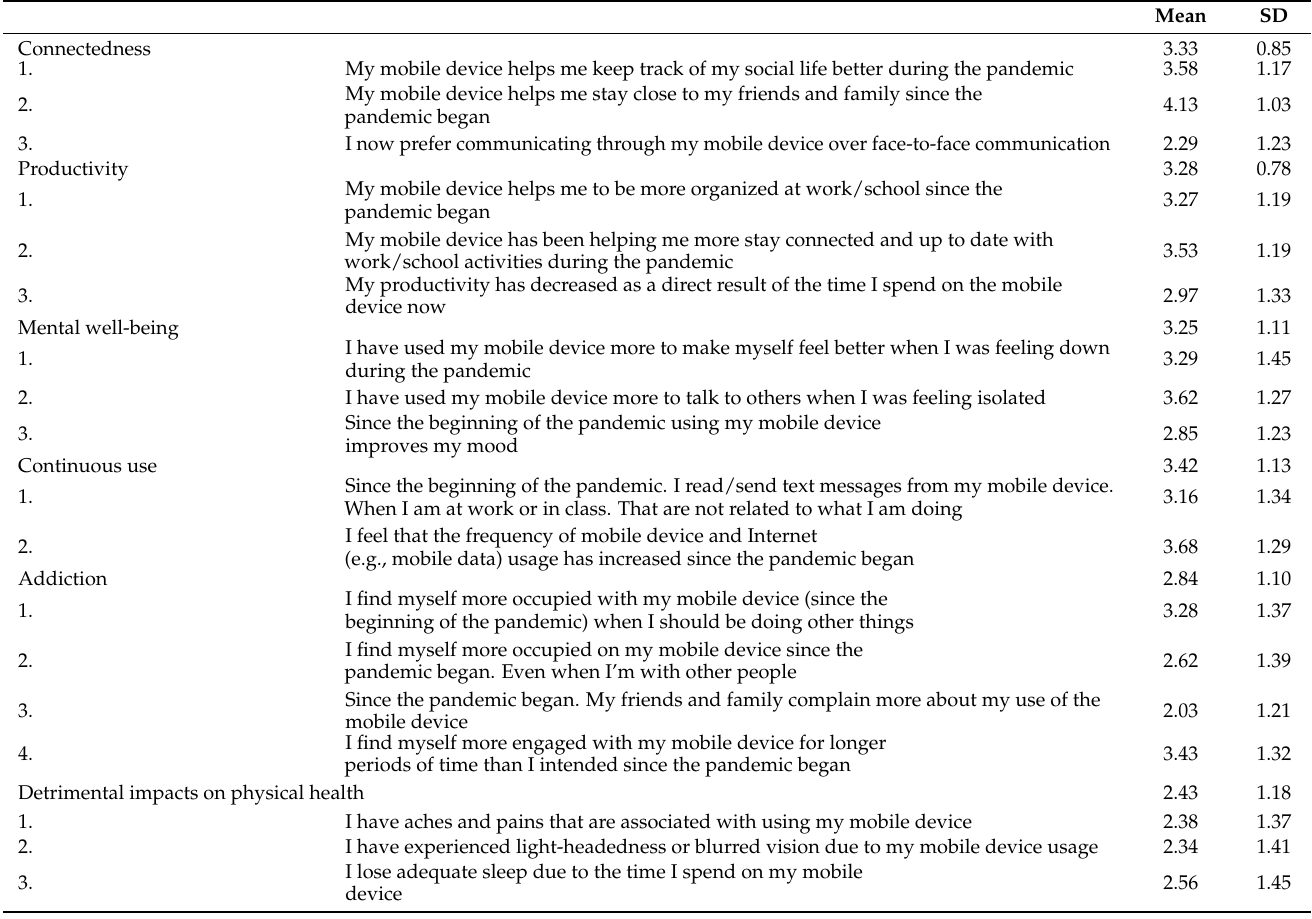
Table A9. Mobile Device Use and Affinity Subscale Questions, Means, and Standard Deviations